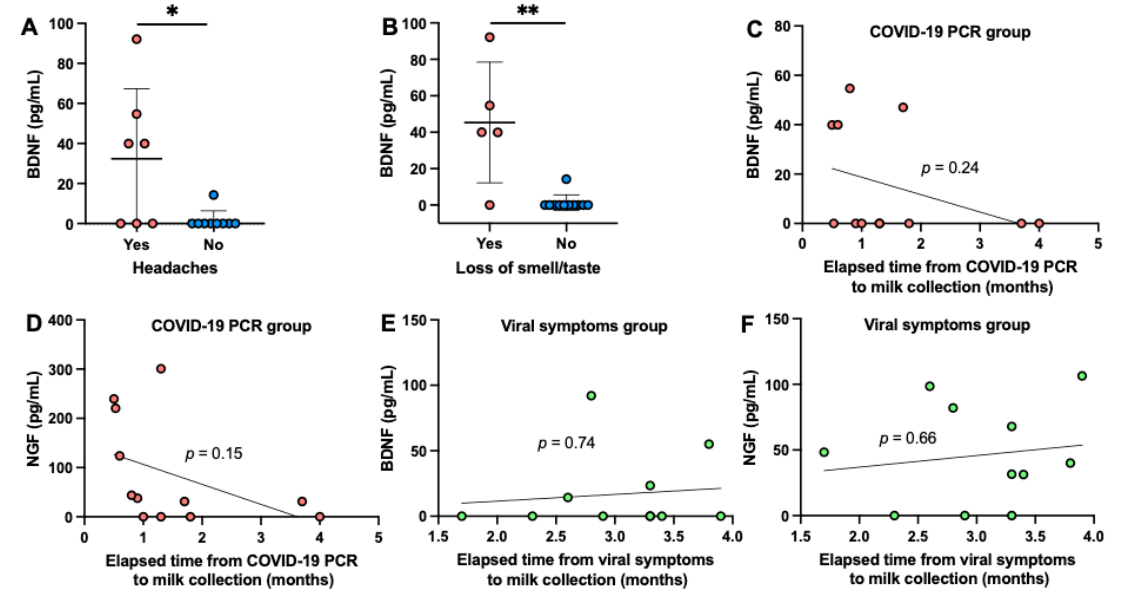
Figure 2. Effect of viral symptoms (likely related to the central nervous system) and elapsed time from infection to milk collection on the concentration of brain-derived neurotrophic factor (BDNF) and nerve growth factor (NGF) in human milk. ( A ) BDNF concentration in mothers with headaches ( n = 7) and mothers without headaches ( n = 9) during COVID-19 infection. ( B ) BDNF concentration in mothers with loss of smell/taste ( n = 5) and mothers without loss of smell/taste